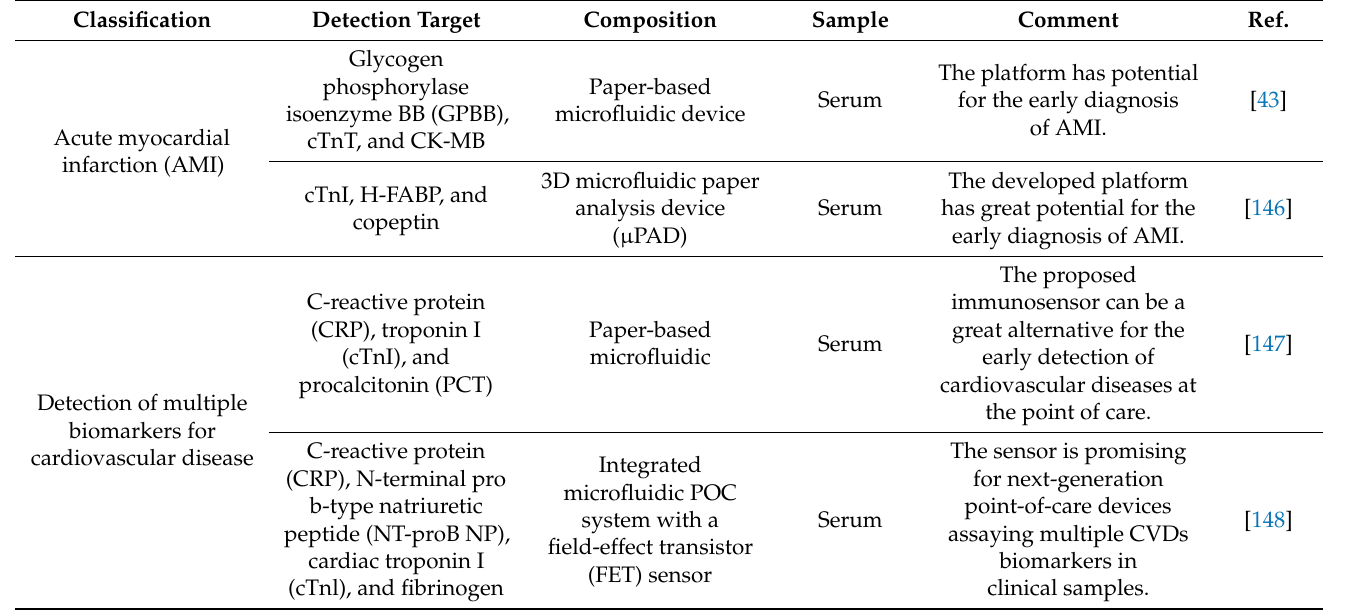
Table 4. The overview of applications of microfluidic POC devices in early diagnosis of cardiovascular